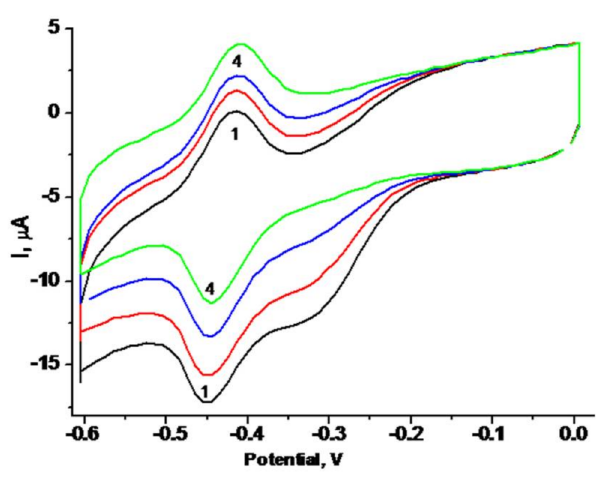
Figure 6. Cyclic voltammograms (CV) of the GO/gCuHCF/GE. CV profiles (1–4) as outputs upon addition of glucose up to concentrations: (1) 0, (2) 0.17, (3) 0.5, (4) 1.3 mM. Conditions: scan rate 50 mV · s − 1 ; Ag/AgCl (reference electrode) in 50 mM PB, pH 6.5. The sensing layer of the biosensor contains 0.5 mU of PO-like gCuHCF and 40 mU of